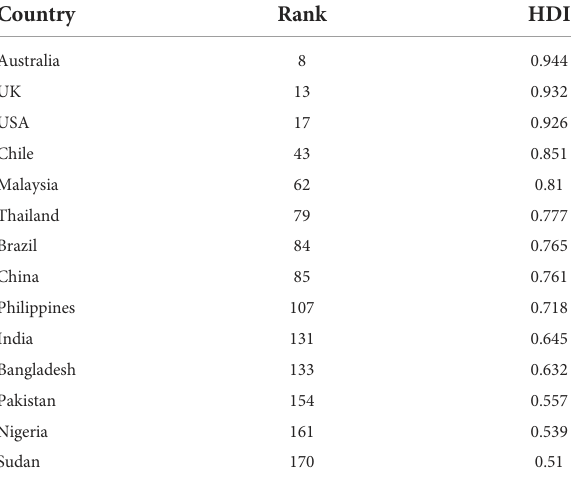
TABLE 4 United Nations Human Development Report 2020 Ranking and HDI score of countries included in this study. Country Rank